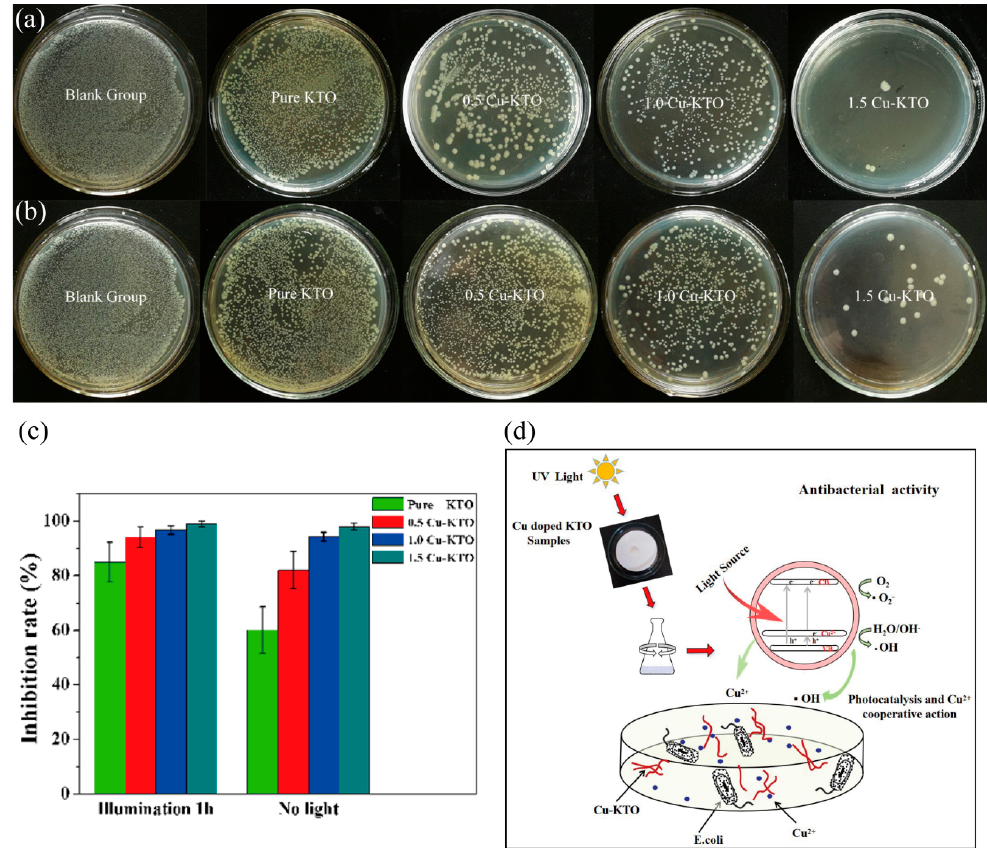
Figure 7. The optical images of E. coli cultured for 24 h in the presence of different samples irradiated by UV light ( a ) and without light ( b ); antibacterial rate (%) against E. coli ( c ); schematic diagram of antibacterial mechanism of Cu–KTO nanowires ( d ).